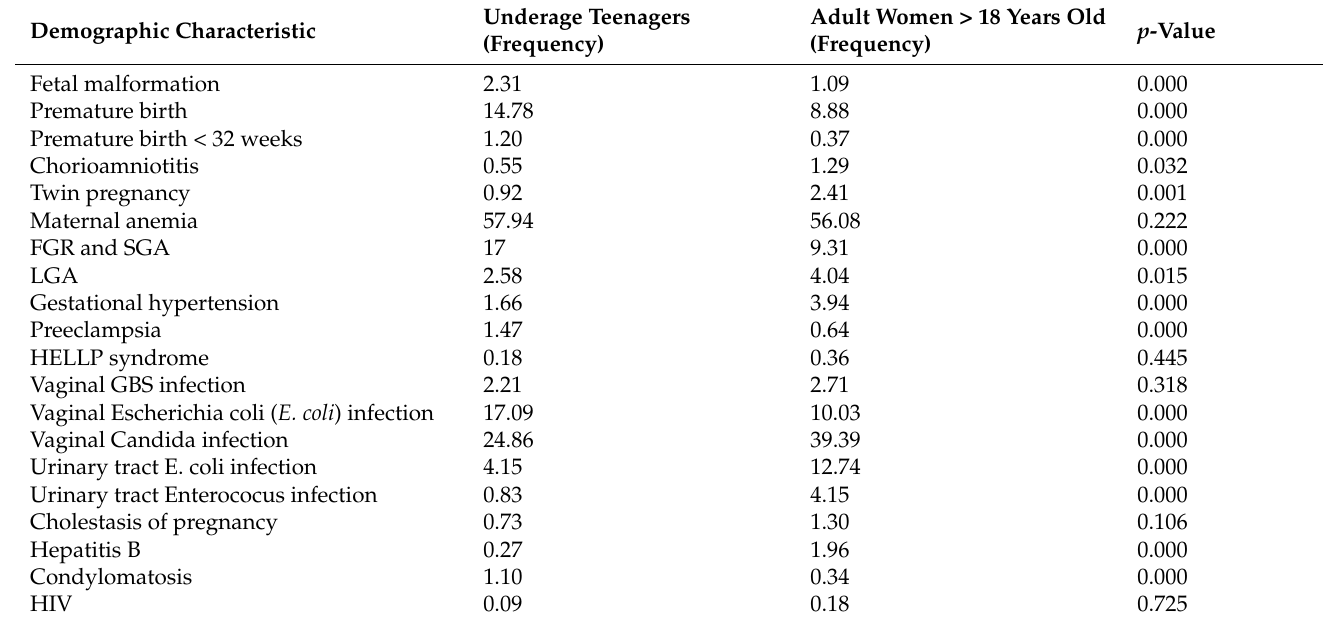
Table 6. Comparison between underage adolescents and pregnant women over 18 years of age concerning the the associated